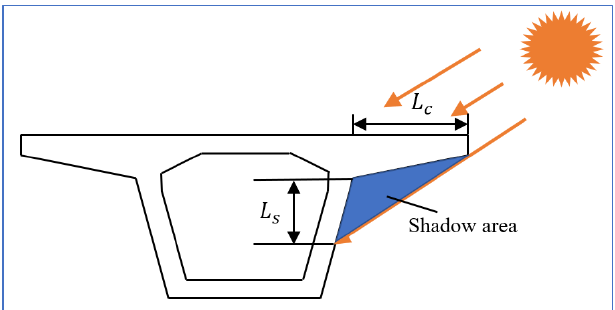
Figure 14. The shadow occlusion relationship diagram of the box - girder web.